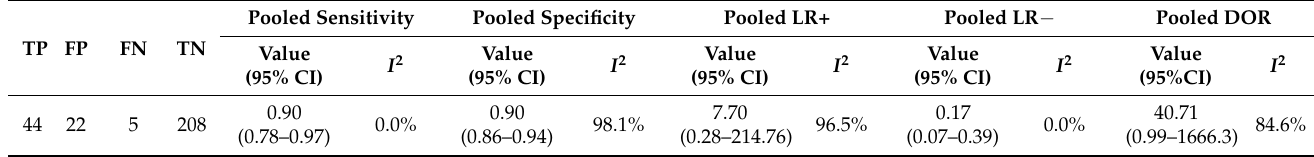
Table 4. Results of pooled data.